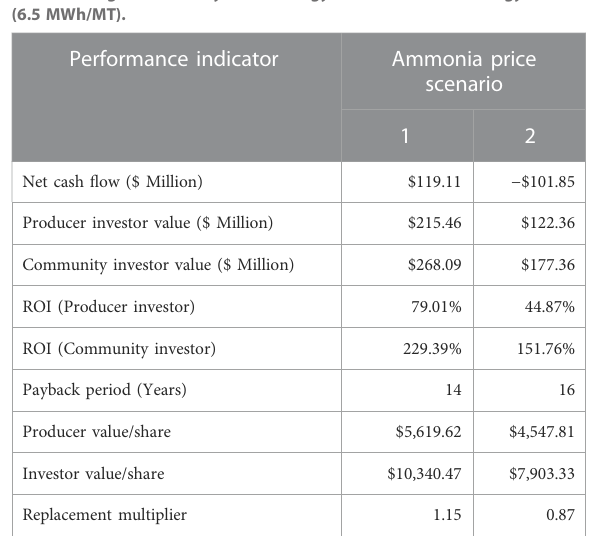
TABLE 10 Discounted performance indicators under debt fi nancing I (producers = 35%; community = 40%; debt = 25%) with a discount rate